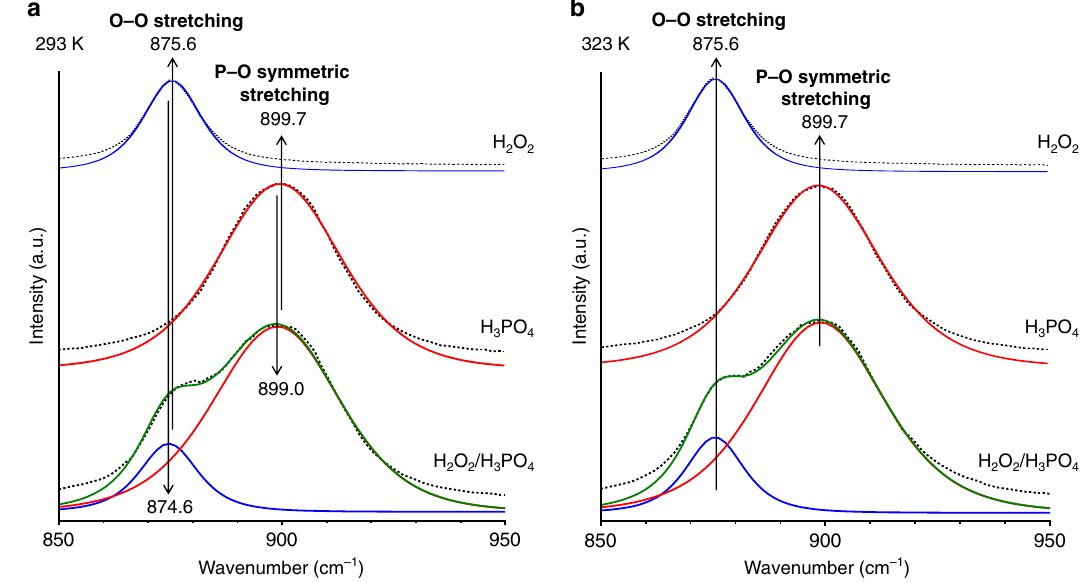
Fig. 6 Raman spectra (850 – 950 cm − 1 ) of (top) H 2 O 2 , (middle) H 3 PO 4 , and (bottom) a mixture of H 2 O 2 and H 3 PO 4 measured at different temperatures. a 293 K. b 323 K. The H 2 O 2 and H 3 PO 4 concentrations are 2 M and 4 M, respectively. The dots are the experimental data, and the solid lines are the deconvoluted components, where the green lines are the sum of the